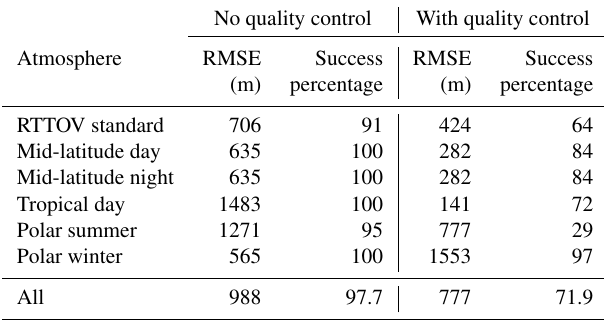
Table 4. Summary of the percentage of accepted retrievals and the RMSE describing the difference between the true (simulated) and retrieved